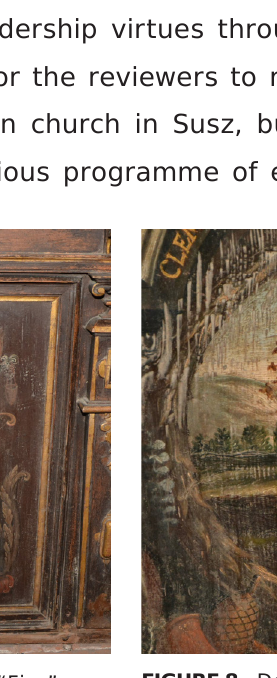
Figure 7 Depiction of emblem “Fire”. Figure 8 Depiction of emblem